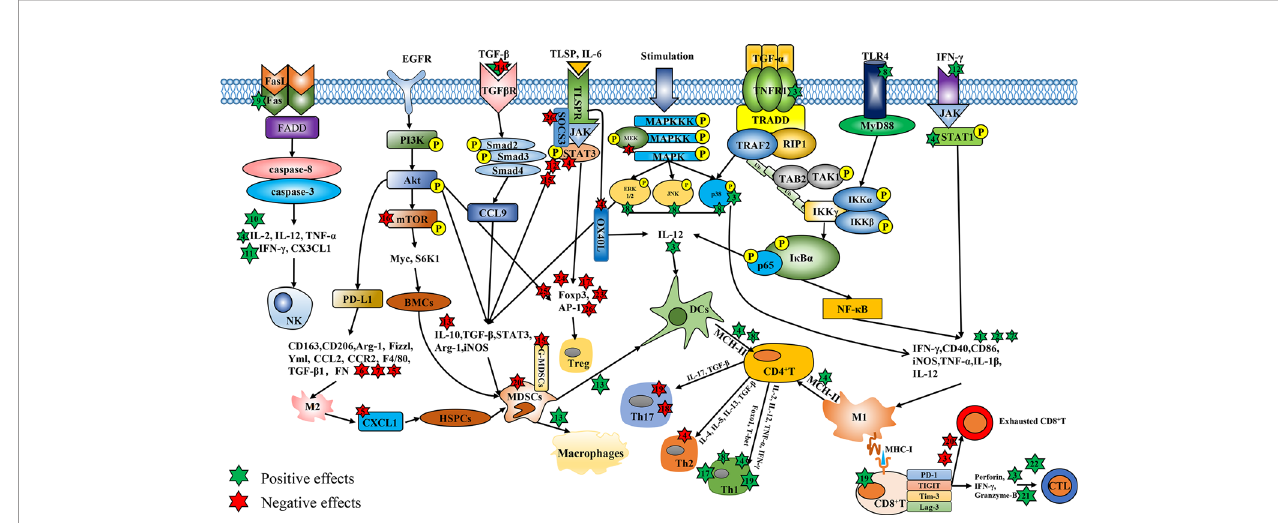
FIGURE 1 | The regulatory effects of Chinese medicine compounds in immune cells. Chinese medicine compounds: 1. Modi fi ed Si-Jun-Zi Decoction; 2. Haimufang decoction; 3. Compound kushen injection; 4. Yu-ping-feng; 5. XIAOPI formula; 6. Dahuang Zhechong Pills; 7. Jianpi Yangzheng; 8. Yangyin Wenyang; 9. Jinfukang; 10. Tien-Hsien liquid; 11. ACNO; 12. Yanghe Decoction; 13. Jianpi Huayu Decoction; 14. Baoyuan Jiedu decoction; 15. Ze-Qi-Tang; 16. Shuangshen granules; 17. Quxie capsule; 18. Compound Sophorae Decoction; 19. JC-001 20. Shugan Jianpi formula; 21. Xiao-Ai-Ping; 22. Shenqi Fuzheng Injection; 23. Feiyanning Decoction; 24. Yi-Yi-Fu-Zi-Bai-Jiang-San; 25. Xihuang Pill; 26. Fuzheng Fangai.